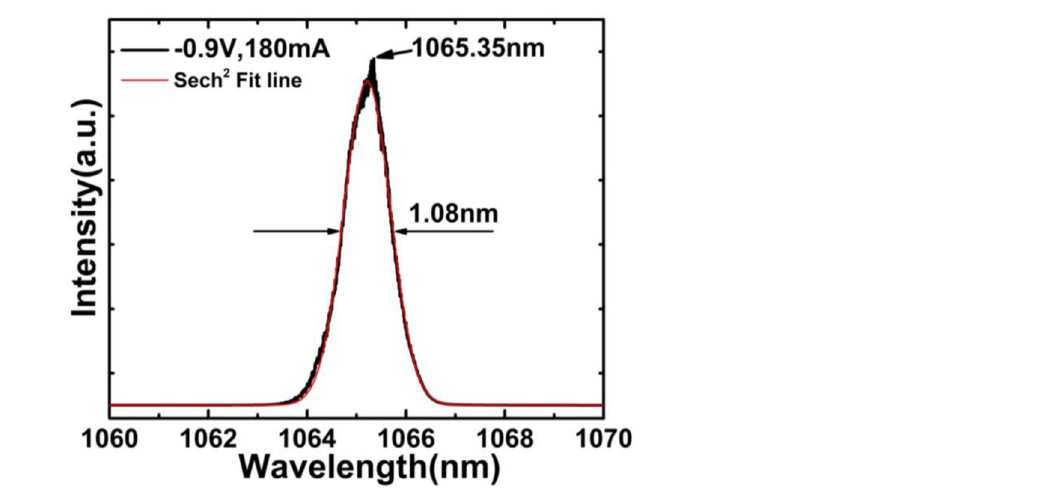
Figure 5. Spectrum of the MLLs when PW = 1.1